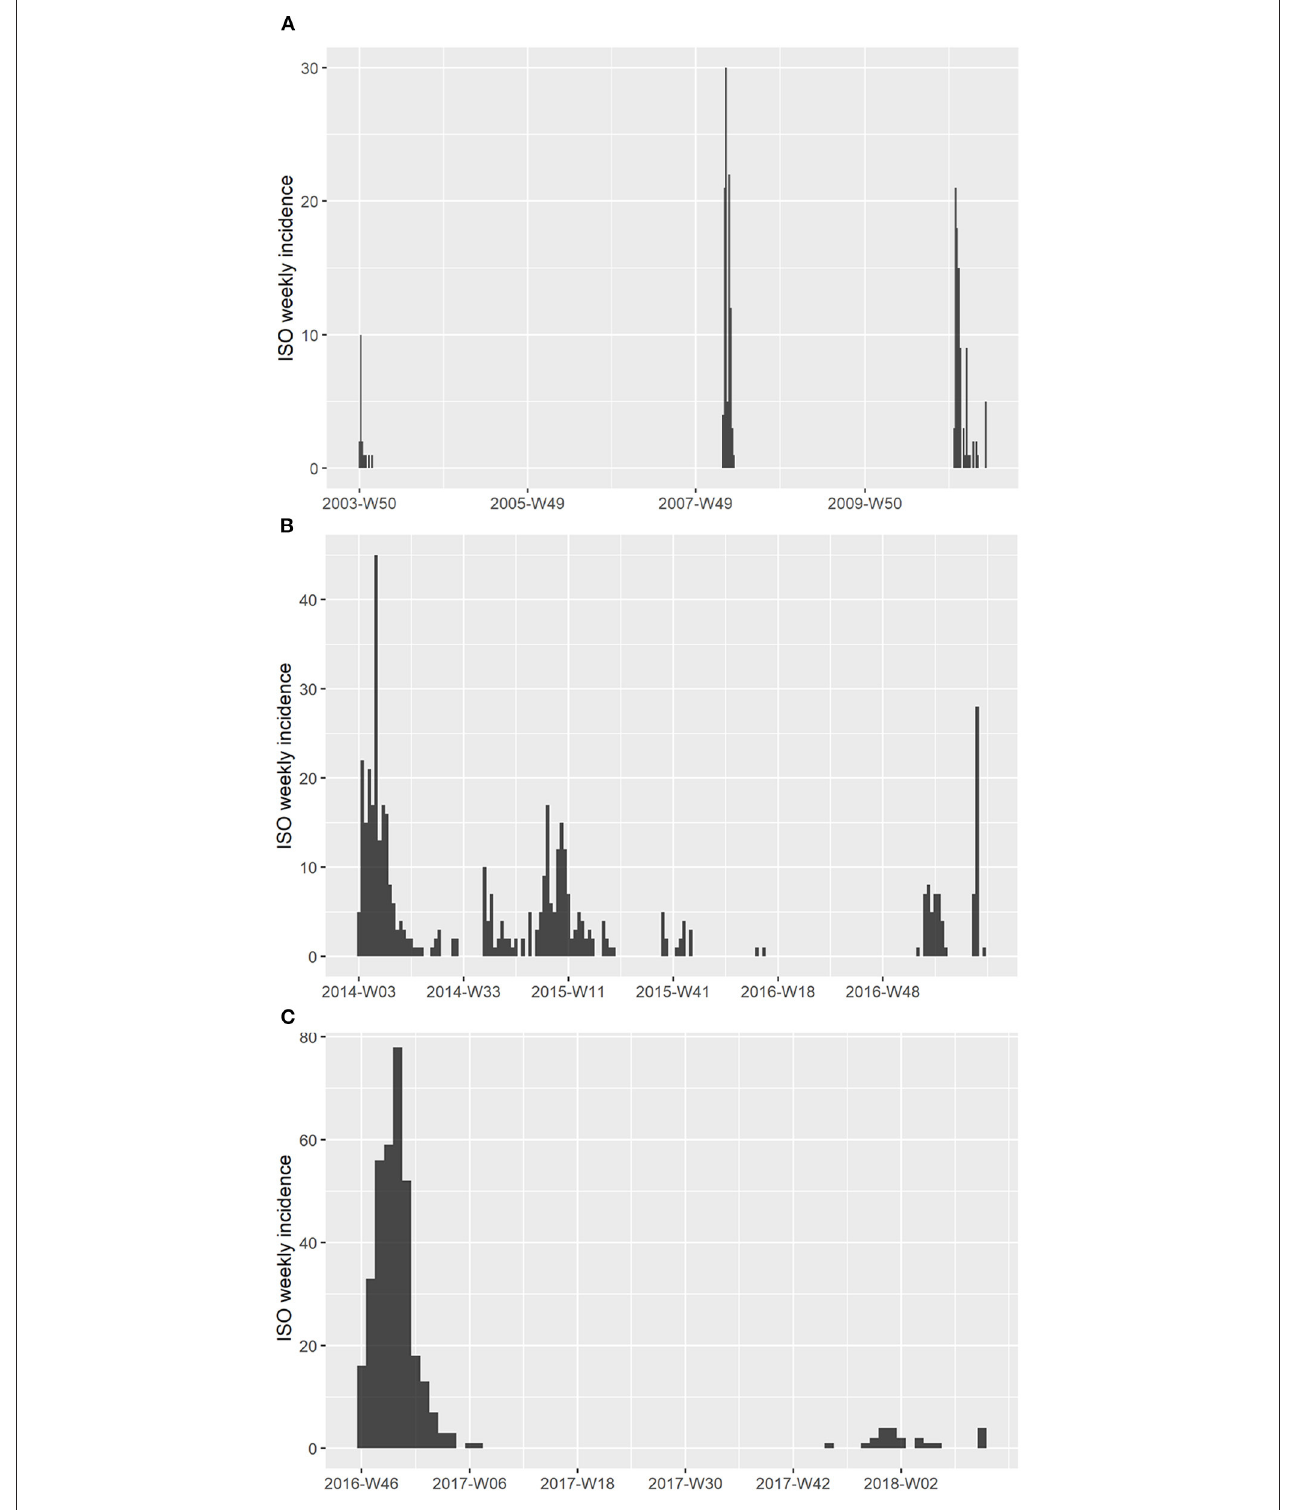
FIGURE 1 | Epidemic curve of HPAI outbreaks in Korea between 2003 and 2018. (A) Weekly epidemic case number of HPAI subtype H5N1 from 2003 to 2011. (B) Weekly epidemic case number of HPAI subtype H5N8 from 2014 to 2017. (C) Weekly epidemic case number of HPAI subtype H5N6 from 2016 to 2018. The x-axis represents the week numbers, which were based on the ISO 8601 week date